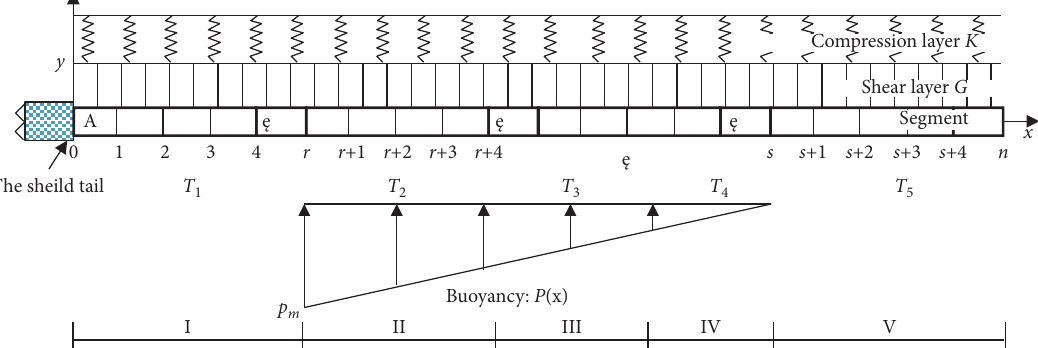
Figure 5: Five segment uplift stages and the Pasternak foundation beam model.